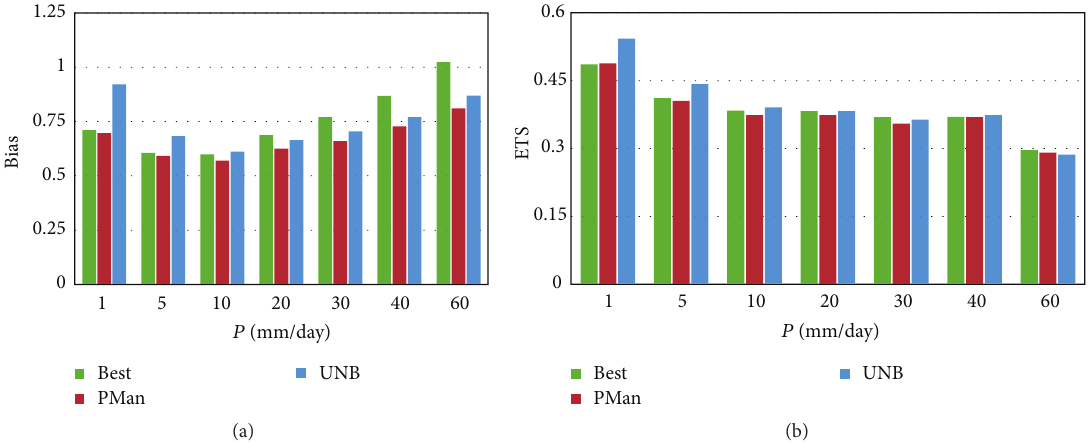
Figure 6: Objective scores for the precipitation over the Italian area: (a) bias; (b) equitable threat score (ETS). Best (green bar) is the best model, PMan (red bar) is the ensemble mean, and UNB (blue bar) is the unbiased ensemble